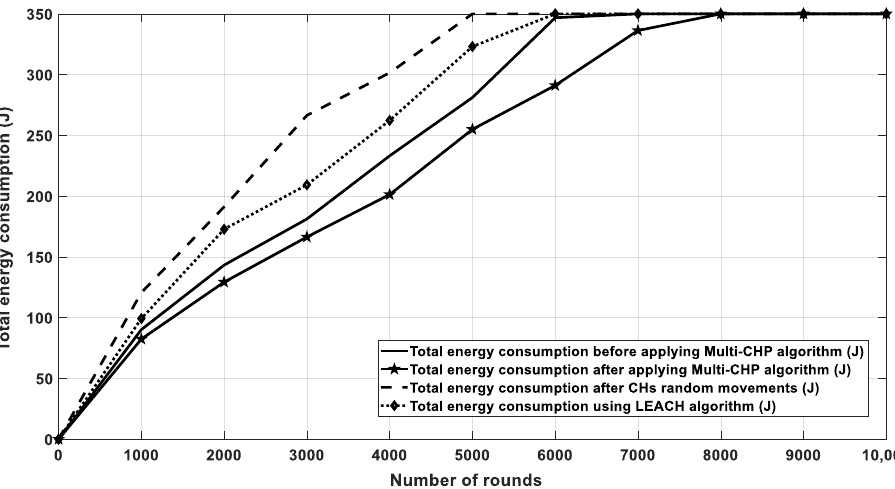
Figure 16. Energy consumption for the proposed algorithm and other related work.